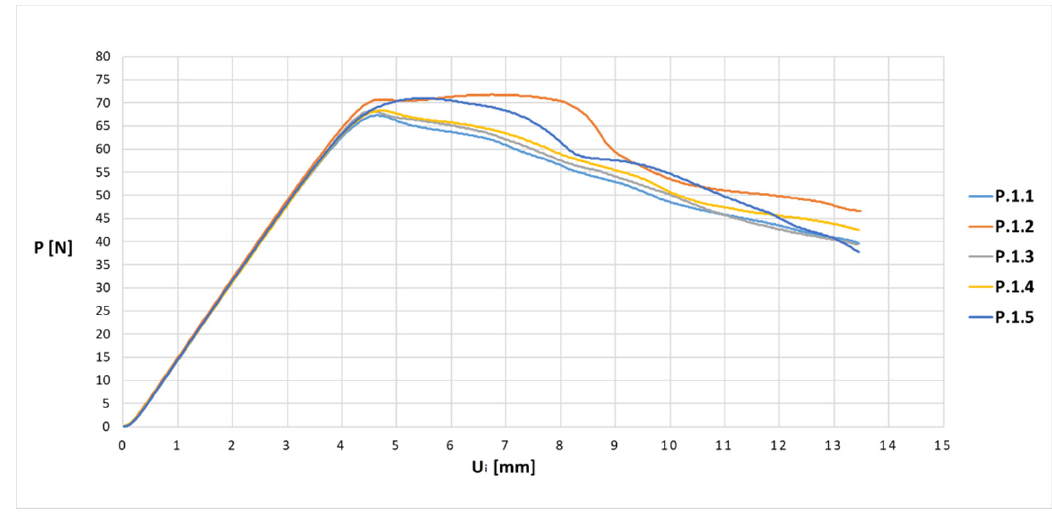
Figure 8. Force–displacement relationship diagram for samples from the P.1 series.